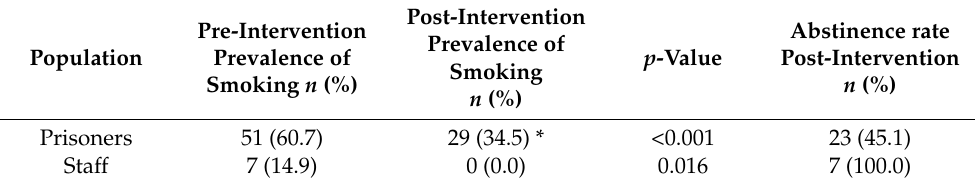
Table 2. Changes in Smoking Behaviours and Abstinence Rates Post- Intervention.